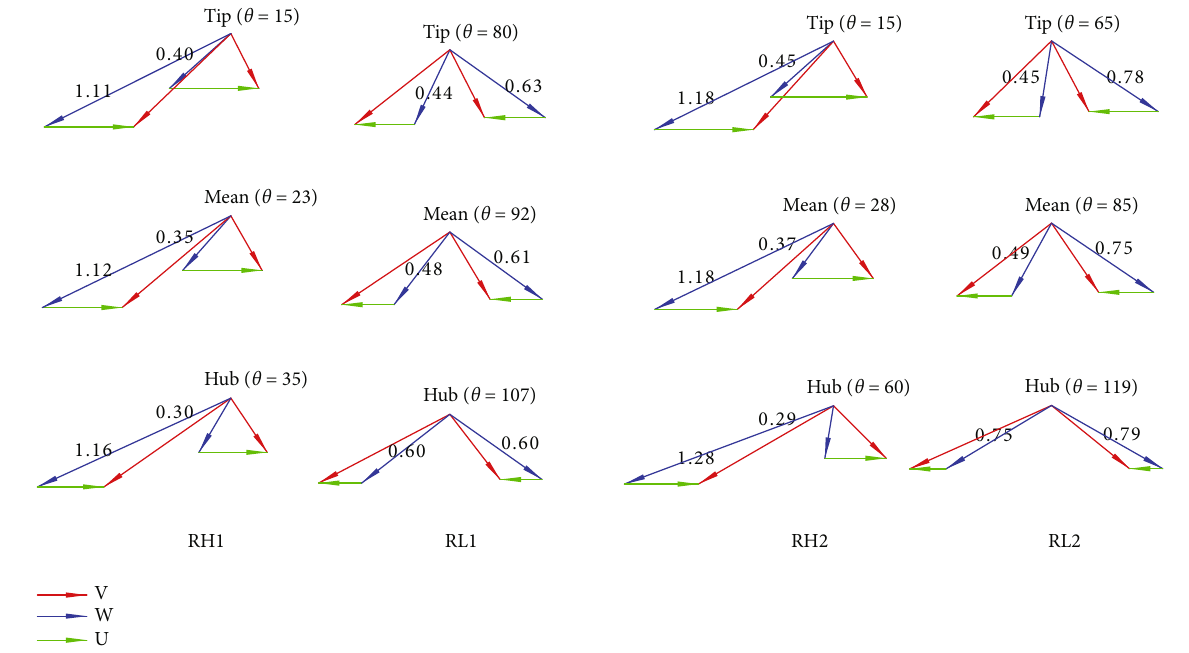
Figure 5: Velocity triangle. Table 3: Meridional design parameters. Aspect ratios (based on axial